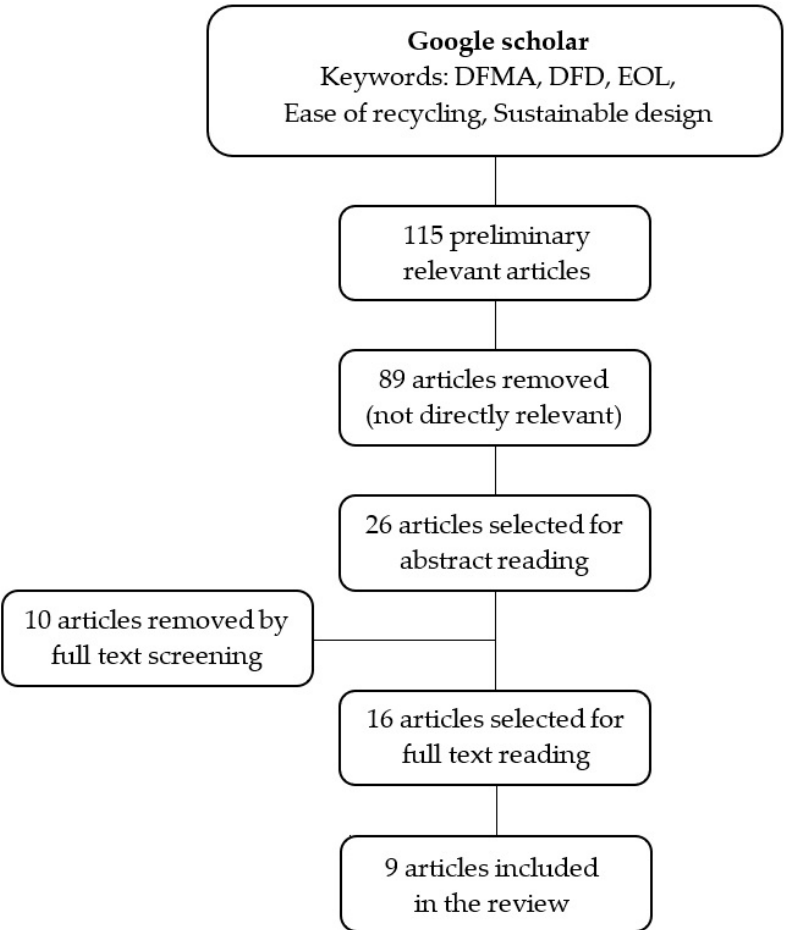
Figure 1. Articles’ screening hierarchy.